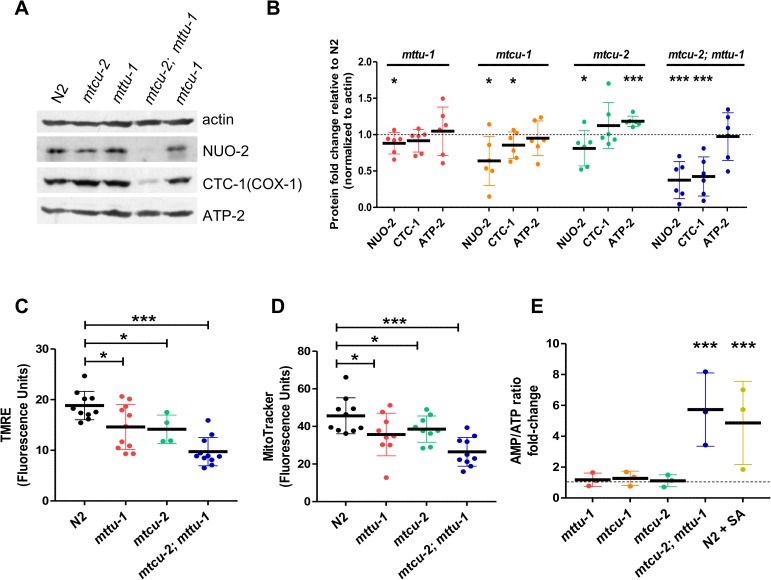
mttu-1, mtcu-1 and mtcu-2 mutants display mild mitochondrial defects.(A) Representative western blot of protein extracts from young adults worms (day 1 of adulthood) probed with antibodies to NUO-2 (complex I), CTC-1(COX-1) (complex IV), ATP-2 (complex V) and actin. (B) Densitometric analysis of blots obtained from at least three independent experiments. The steady state levels of the OXPHOS subunits were normalized with respect to actin and are represented as the equivalent amounts in wild type. Error bars indicate standard deviation (SD). * denotes p<0.05, ***, p = 0.0001. (C, D) Quantitation of (C) TMRE staining (n>4) (D) and MitoTracker Red staining (n>9) in L4 worms during 16 h. *p<0.05, ***p = 0.0002. (E) Graph showing the AMP/ATP ratio in the indicated strains at L4 stage. The wild-type strain (N2) treated for 2 h with 1 mM sodium azide (SA), which blocks ATP production, was included in the analysis as a positive control (n = 3). ***p<0.001. Statistical significance was evaluated with Student’s unpaired t-test. Data is represented as mean ± SD.